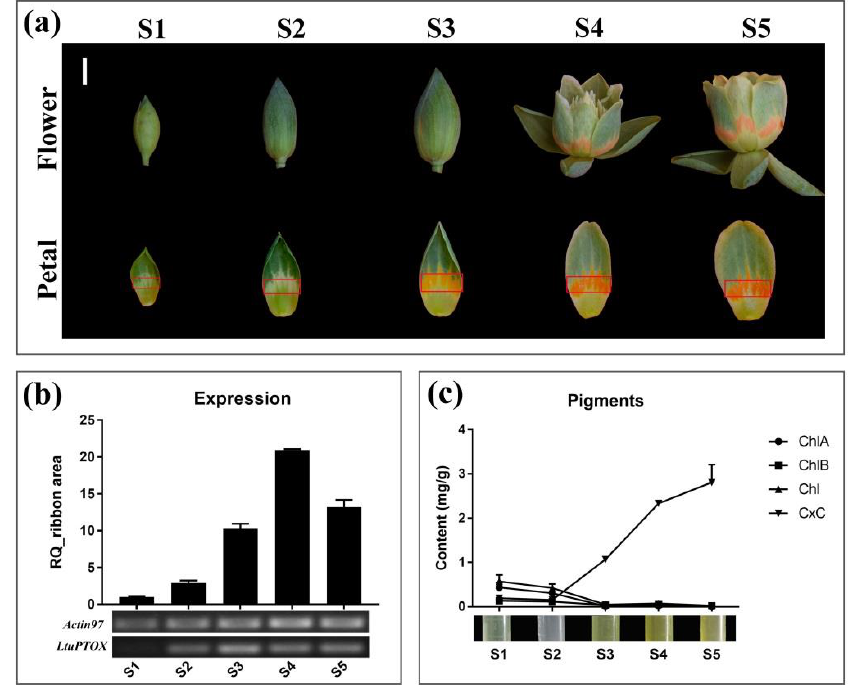
Figure 5. Changes in pigment content and gene expression in the orange bands of Liriodendron petals during di ff erent developmental stages. ( a ), the di ff erent developmental stages, i.e., S1, female flower buds begin to enlarge, and the flower bud is as hard as a marble; S2, intermediate developmental stage of female flowers, when the flower buds begin to soften; S3, later enlargement phase of the flower bud, when the orange band of the petals appears yellow; S4, the flower buds are preparing to open, and the color of the orange band of the petals begins to deepen; and S5, the peak flowering period of Liriodendron flowers, when pollination and fertilization begin. The orange band marked by a red box on each of the petals was used for RNA extraction and pigment determination, and the bar is 1 cm; ( b ), Changes in the expression level of the LtuPTOX gene from S1 to S5. ( c ), Changes of the four pigments content in di ff erent developmental stages, including Chlorophyll A (ChlA), Chlorophyll B (ChlB), total Chlorophyll (Chl), and Carotenoids (CxC).